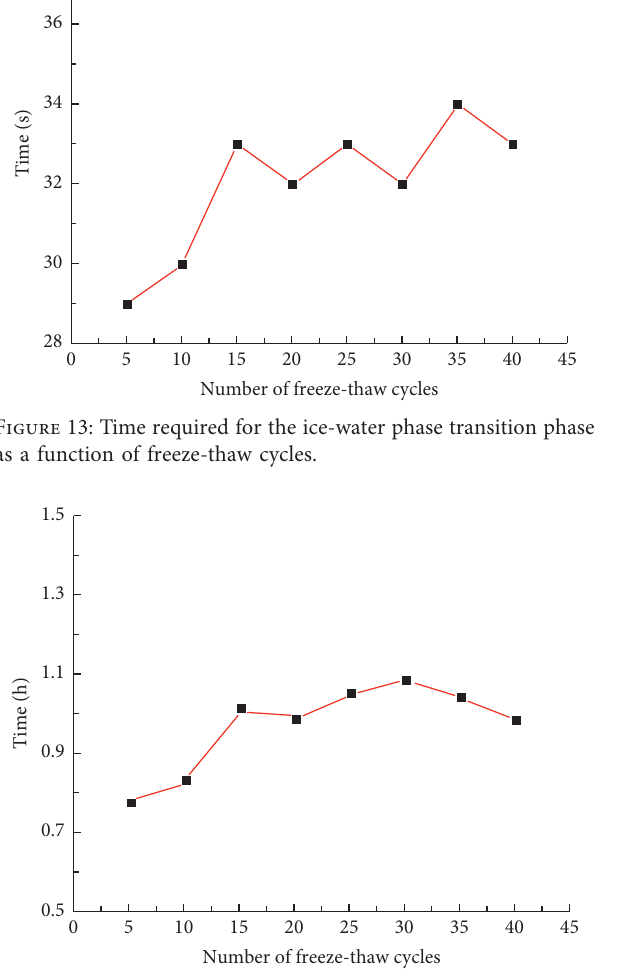
Figure 14: Time required for the deep thaw phase as a function of freeze-thaw cycles.